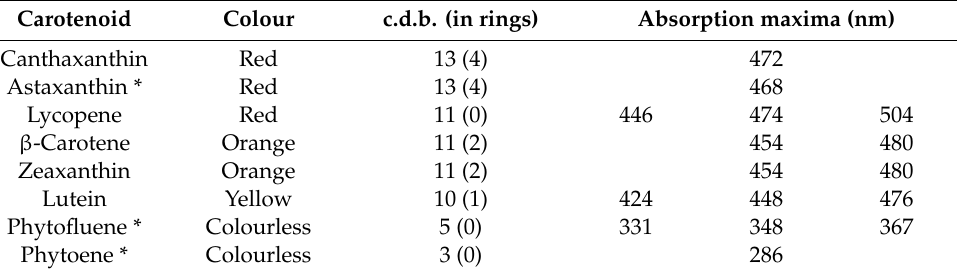
* Absorption maxima in petroleum ether.